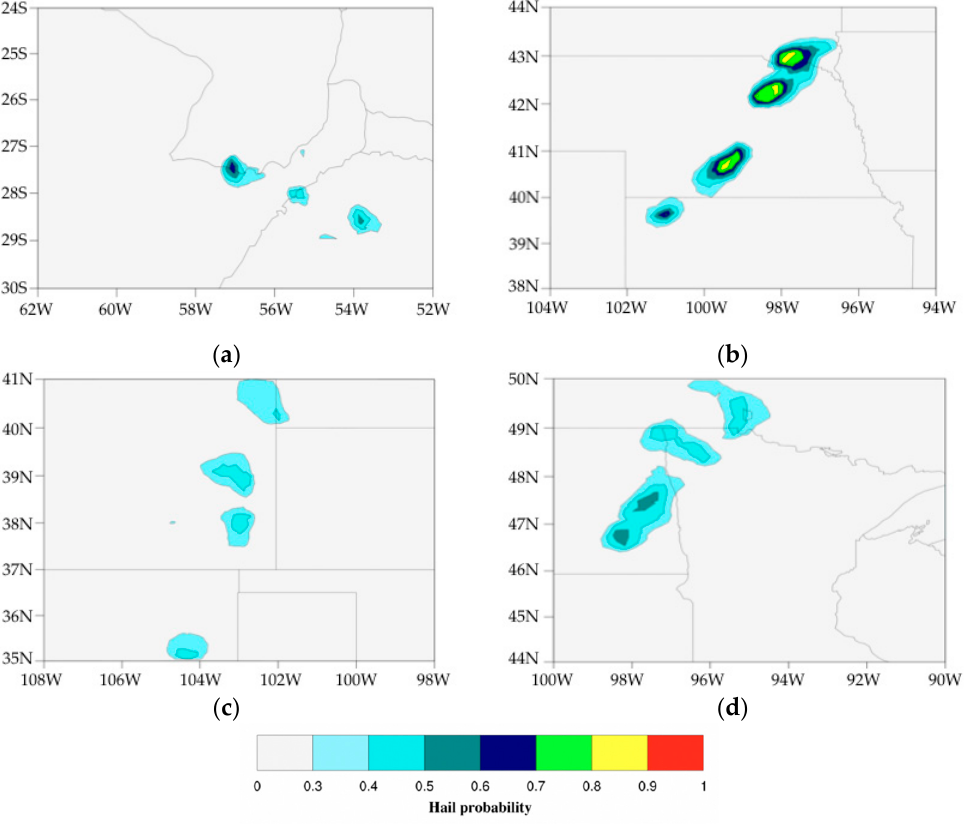
Figure 12. Hail probability as calculated by the MWCC-Hail for hailstorms over ( a ) Argentina (Colonia) 13 Nov 2017 2136 UTC, ( b ) South Dakota (Charles) 21 Aug 2007 2341 UTC, ( c ) Colorado–New Mexico 9 May 2017 0337 UTC, and ( d ) Minnesota–North Dakota 10 Jun 2017 0237 UTC.